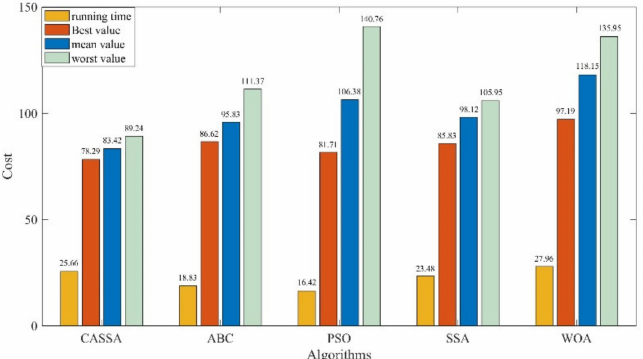
Figure 10. The statistical results of CASSA, ABC, PSO, SSA, and